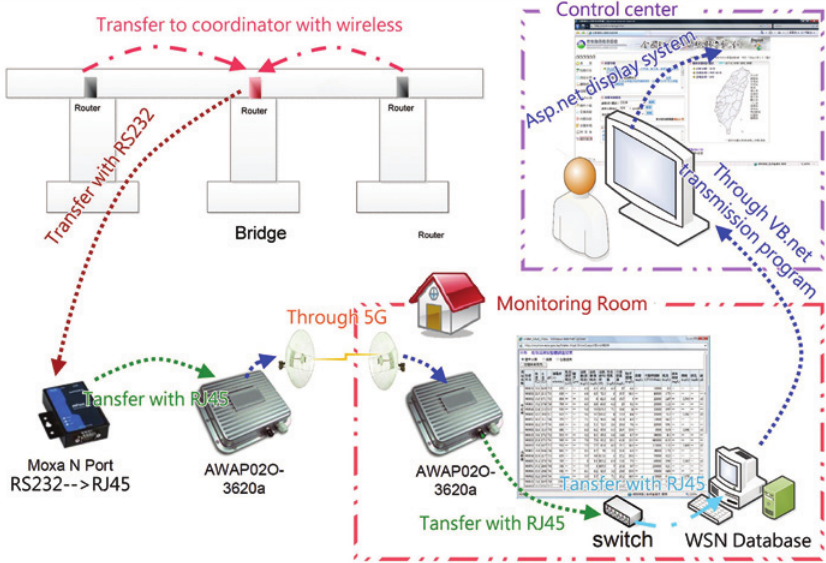
Fig. 4. The processes of the bridge scour monitoring system